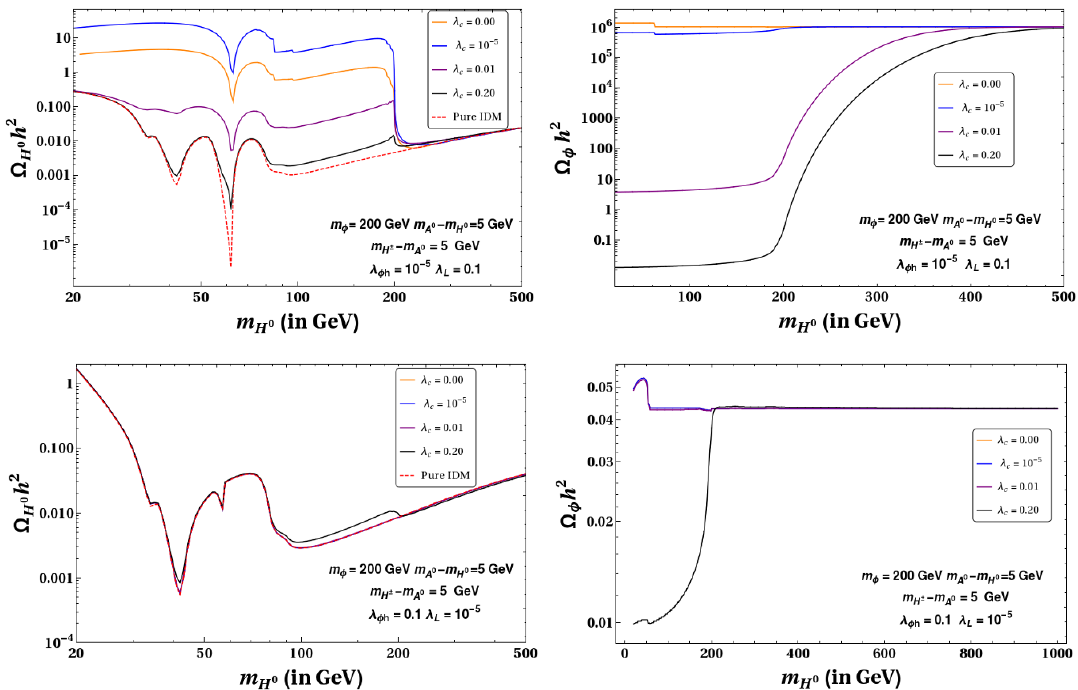
Figure 10 . Relic Density of IDM, H 0 (left panel) and scalar DM, (cid:30) (right panel) as a function of IDM mass m , with di(cid:11)erent choices of (cid:21) c . We illustrate two di(cid:11)erent combinations of DM-SM H 0 couplings, in the top panel: f (cid:21) (cid:30)h = 10 (cid:0) 5 ; (cid:21) L = 0 : 1 g and in bottom panel: f (cid:21) (cid:30)h = 0 : 1 ; (cid:21) L = 10 (cid:0) 5 g . Other parameters kept (cid:12)xed, are mentioned in the inset of each